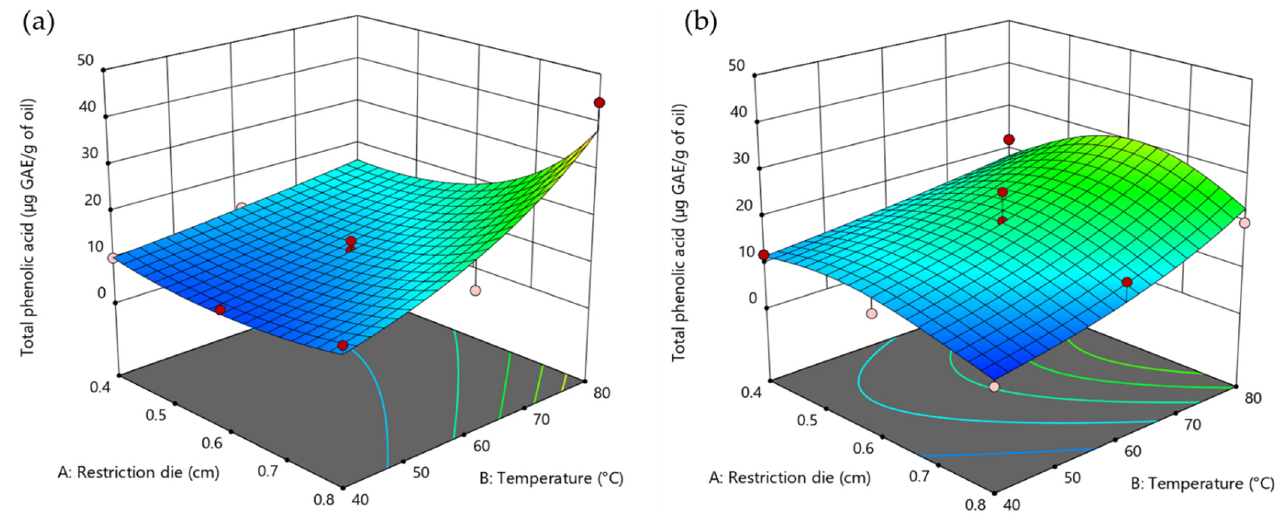
Figure 4. Response surface plot showing the effect of temperature and restriction die size on total phenolic content of CSO. ( a ) Sieve size: >1.4 mm, ( b ) Sieve size: <1.4 mm.